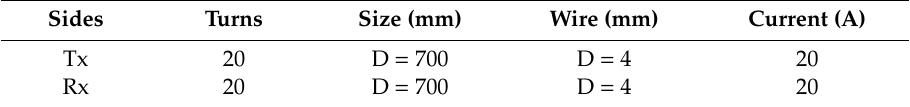
Table 1. Magnetic coupler characteristics for both receiving (Rx) and transmitting (Tx) sides.